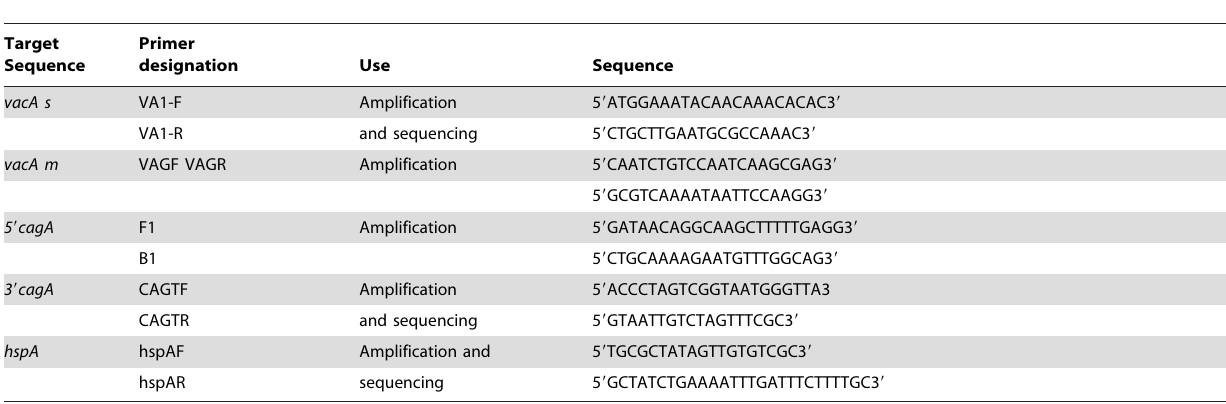
Table 6. Primers used for amplification and sequencing of vacA, cagA and hspA genes.